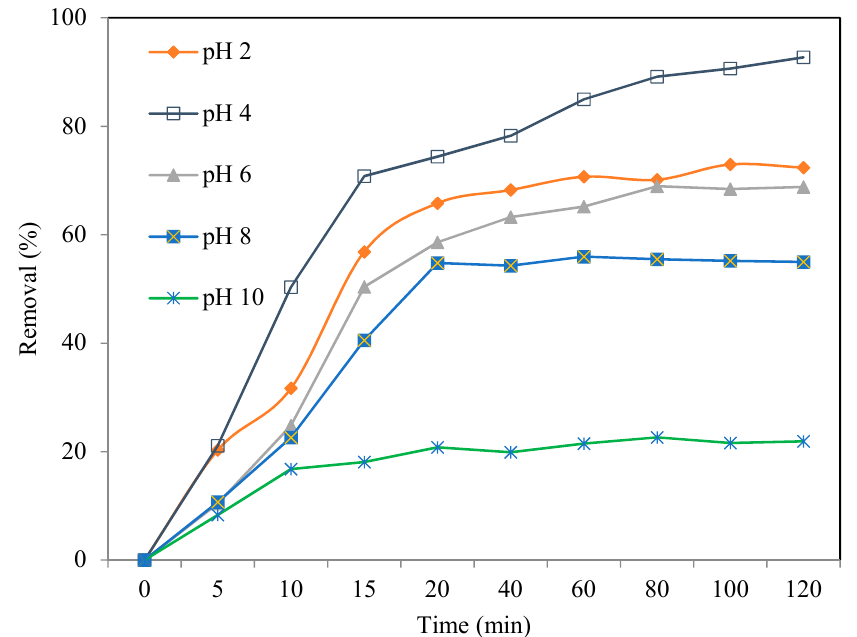
Figure 6. Effect of TC solution pH on Cu 7 S 4 (250 °C) (dosage: 80 mg/L, irradiation time: 120 min, TC: 50 mg/L).